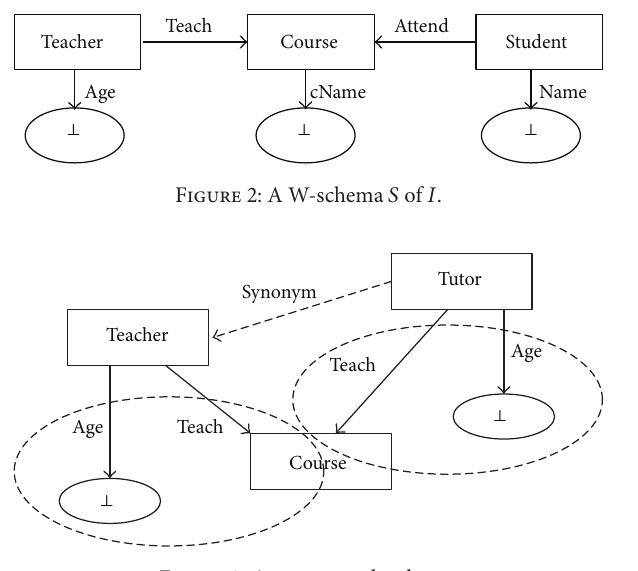
Figure 3: A concept redundancy.